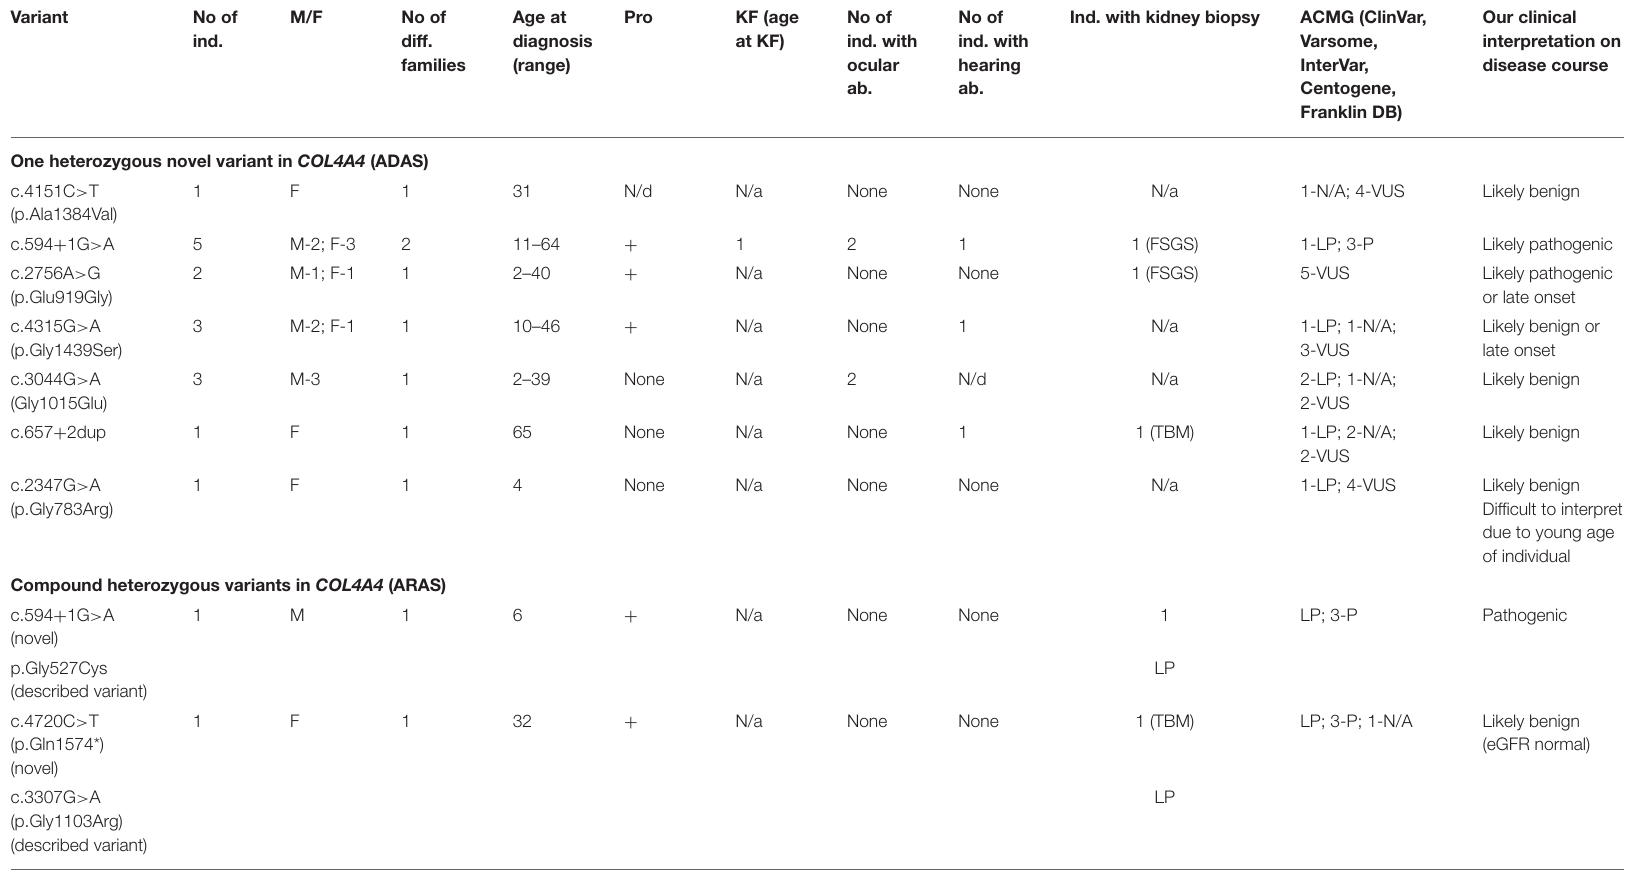
TABLE 6 | Summary of novel COL4A4 variants found in a study (ARAS and